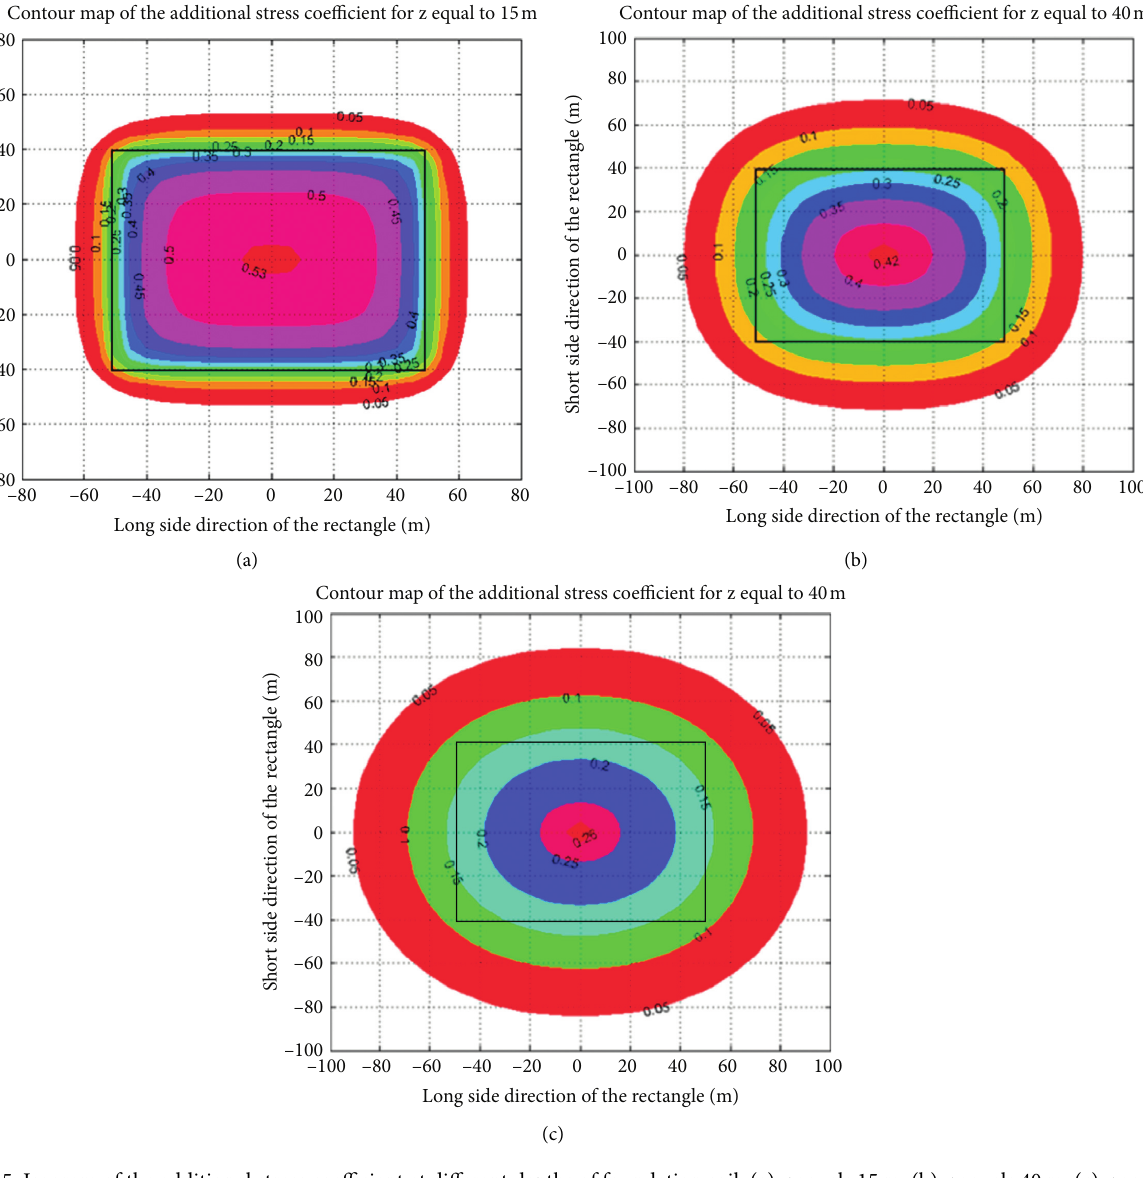
Figure 5: Isogram of the additional stress coefficient at different depths of foundation soil. (a) z equals 15 m; (b) z equals 40m; (c) z equals